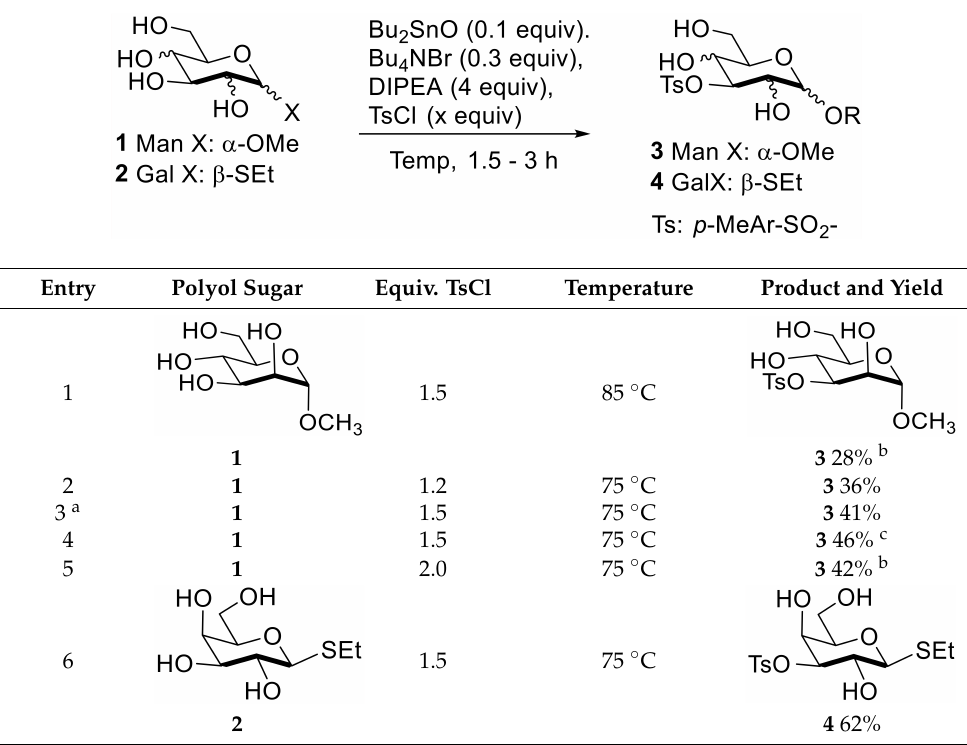
Table 1. Regioselective tosylation of saccharide tetrols.